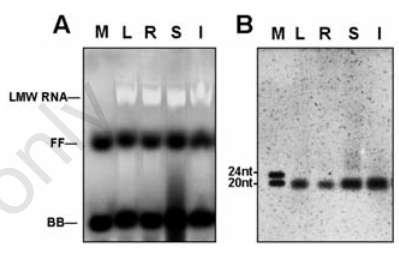
Figure 2. Northern blotting of Arabidopsis microRNA MIR319C. 30 microgram LMW RNA extracted from different Arabidopsis tissues using LSC buffer were run on 15% denaturing urea PAGE gel (20 volts/cm, 1 h). (A) Photogram of ethidium bromide stained PAGE gel. (B) Blotting result using the 5’- digoxigenin labeled complement probe of MIR319C. Lane M, 10 pg 20 and 24 nt digoxigenin labeled DNA marker; Lane L, leaf; Lane R, root; Lane S, stem; Lane I, inflorescence; LMW RNA, band of low-molecular-weight RNA; FF, band of xylene cyanol FF; BB, band of bromophenol